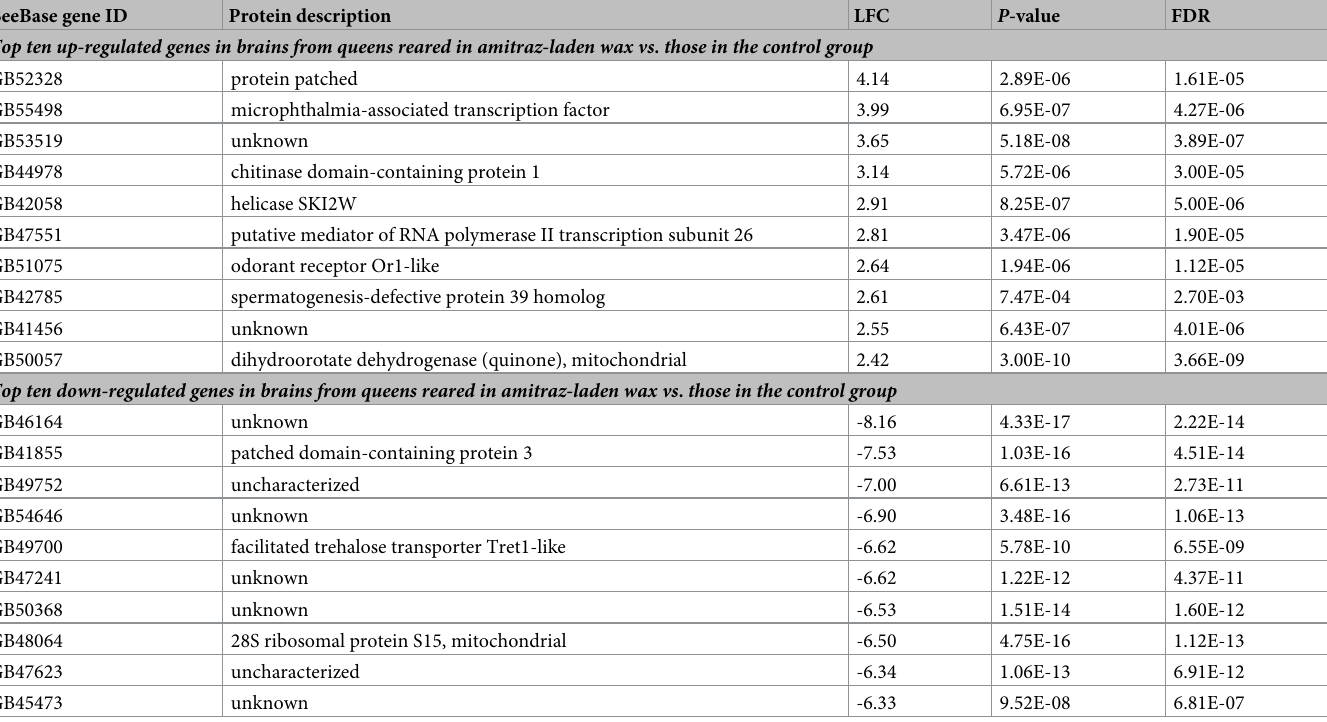
Table 3. The top ten and bottom ten genes that were differentially expressed in brain tissue from queens reared in amitraz-laden wax compared to those reared in untreated wax (control group), ranked by their log 2 fold change (LFC). "FDR" is the false discovery rate. BeeBase gene ID Protein description LFC P -value FDR Top ten up-regulated genes in brains from queens reared in amitraz-laden wax vs . those in the control group GB52328 protein patched